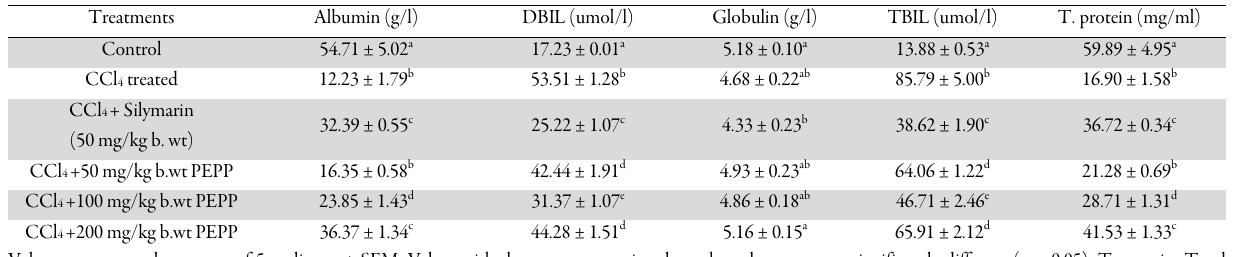
Values are expressed as means of 5 replicates ± SEM. Values with the same superscript along the column are not significantly different (p < 0.05). T. protein: Total Protein; TBIL: Total Bilirubin; DBIL: Direct Bilirubin. Table 5. Effects of PEPP on antioxidant enzymes activity and liver malonaldehyde content of CCl 4 -treated rats Treatments